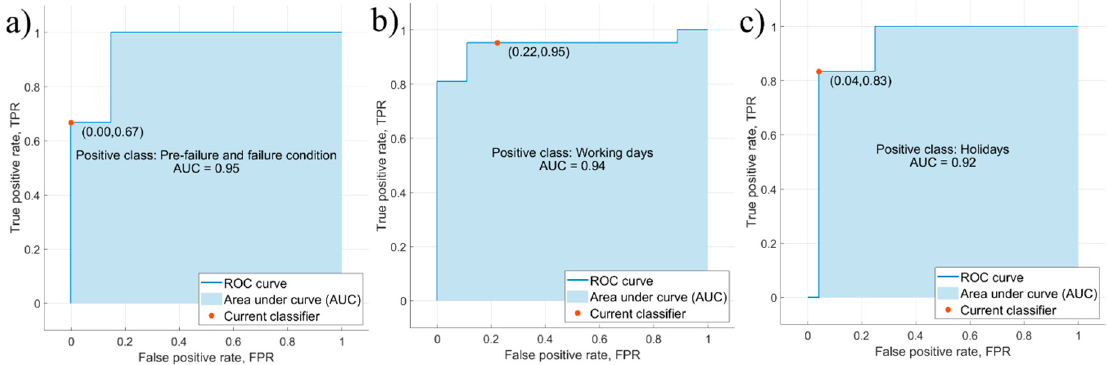
Figure 6. Receiver Operating Characteristic curves for created groups of states of water supply system operation: failure and pre-failure states ( a ), working days ( b ) and holidays ( c ).